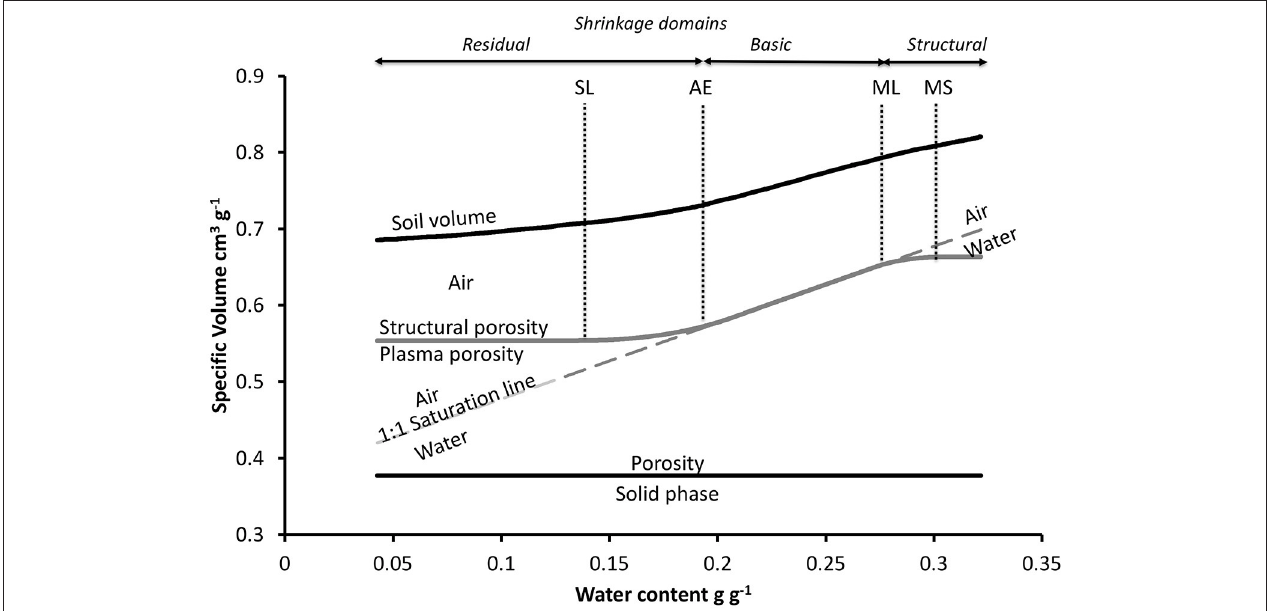
FIGURE 1 | Example of experimental shrinkage curve with fitted XP model (Braudeau et al., 1999), showing the different shrinkage domains, their transition points, and the partitions of the porosity into air and water (load line, dashed gray), and plasma and structural pores (solid gray). SL, plasma shrinkage limit; AE, air entry in the plasma; ML, dry point of the structural porosity; MS, maximum plasma swelling.